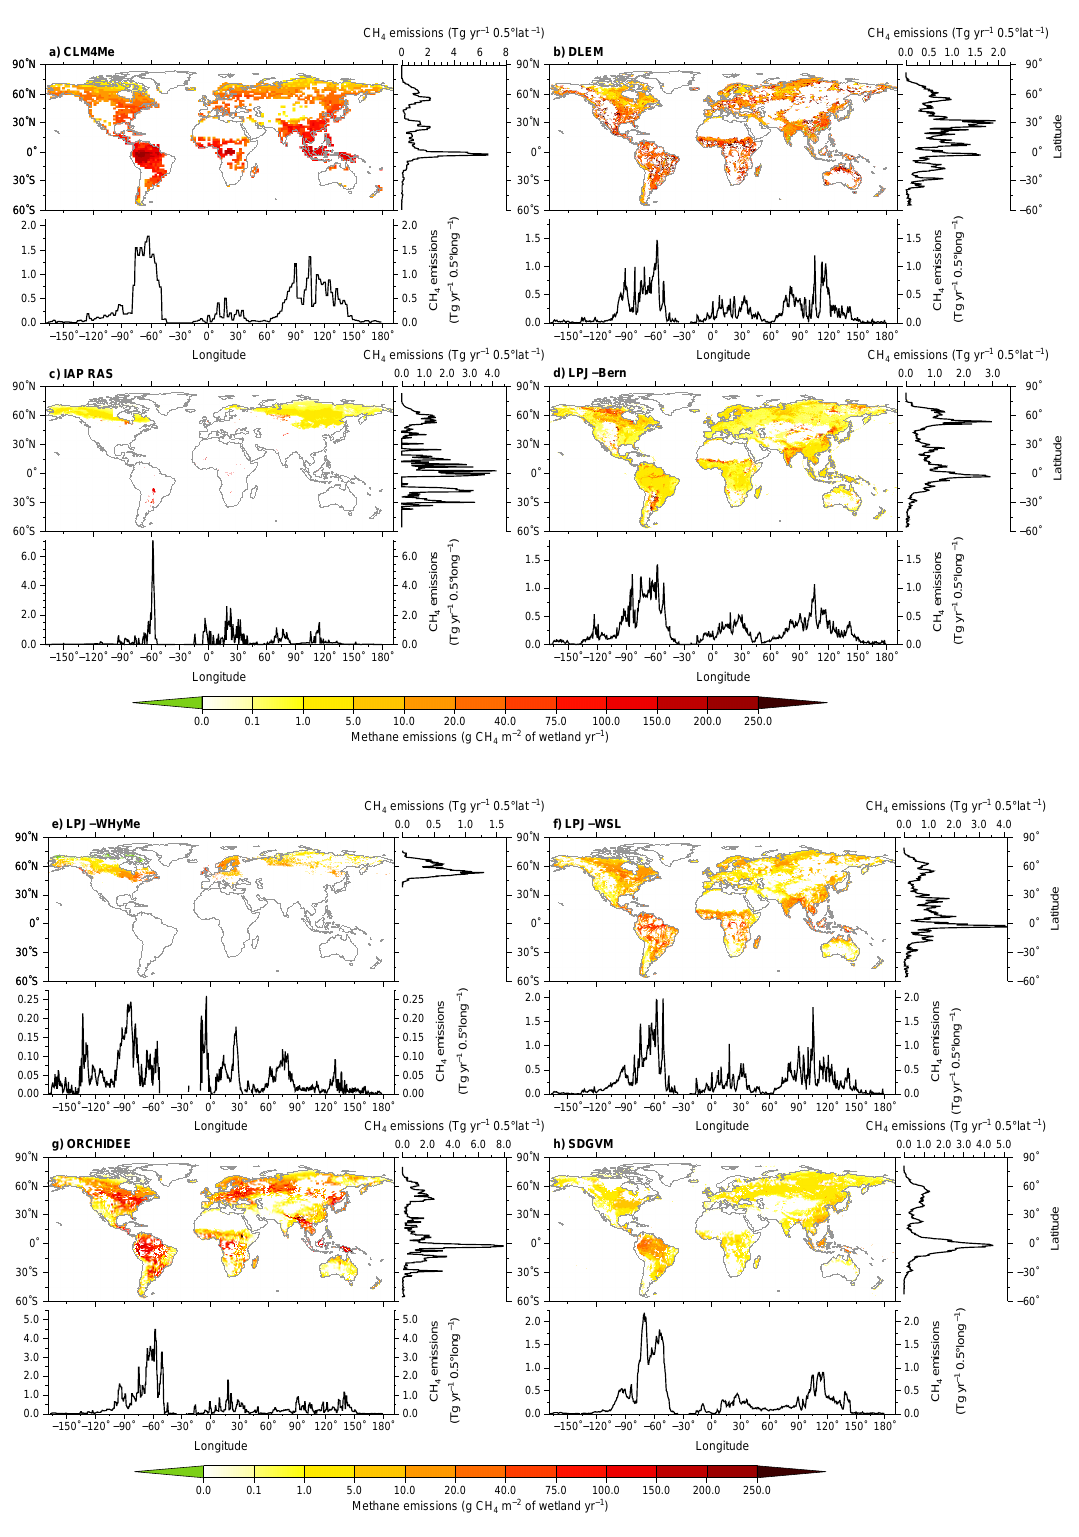
Fig. 4. Global maps of mean annual CH 4 flux intensity per meter squared of wetland with meridional and zonal emission sums for 1993 to 2004. The zonal and meridional sums are per 0.5 ◦ of latitude/longitude. The CLM4Me and ORCHIDEE models were interpolated to a 0.5 ◦ grid to allow inter-comparison with the other